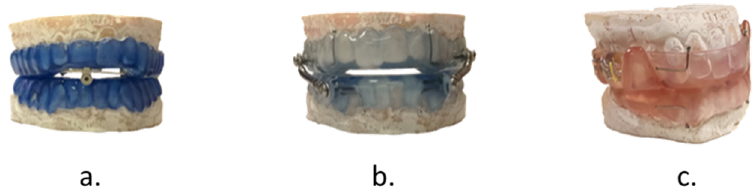
Figure2. Threemodelsofmandibularadvancementdevices: OrthoApnea( a ), Herbst( b ), Somnodent( c Figure 2. Three models of mandibular advancement devices: OrthoApnea ( a ), Herbst ( b ), Somnodent ( c ).